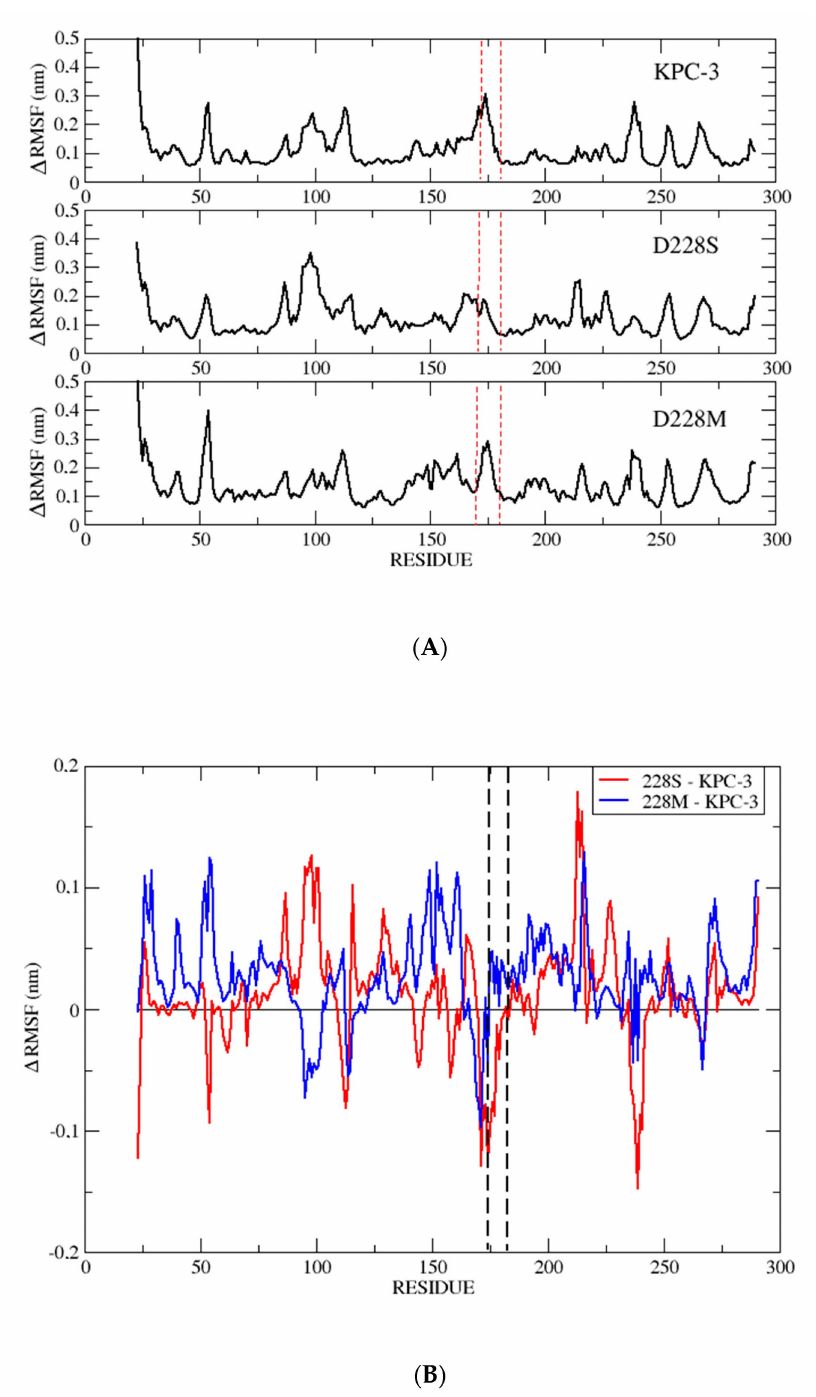
Figure 3. ( A ) C-alpha Root Mean Square Fluctuation of the uncomplexed KPC-3, D228S and D228M, as obtained by 100 ns of simulations disregarding the first 6 ns, which were considered as equilibration. ( B ) Di ff erence between the uncomplexed mutant and KPC-3 Root Mean Square Fluctuation using the data of Figure 3A. The dotted lines (in both panels) indicate the region corresponding to the Ω